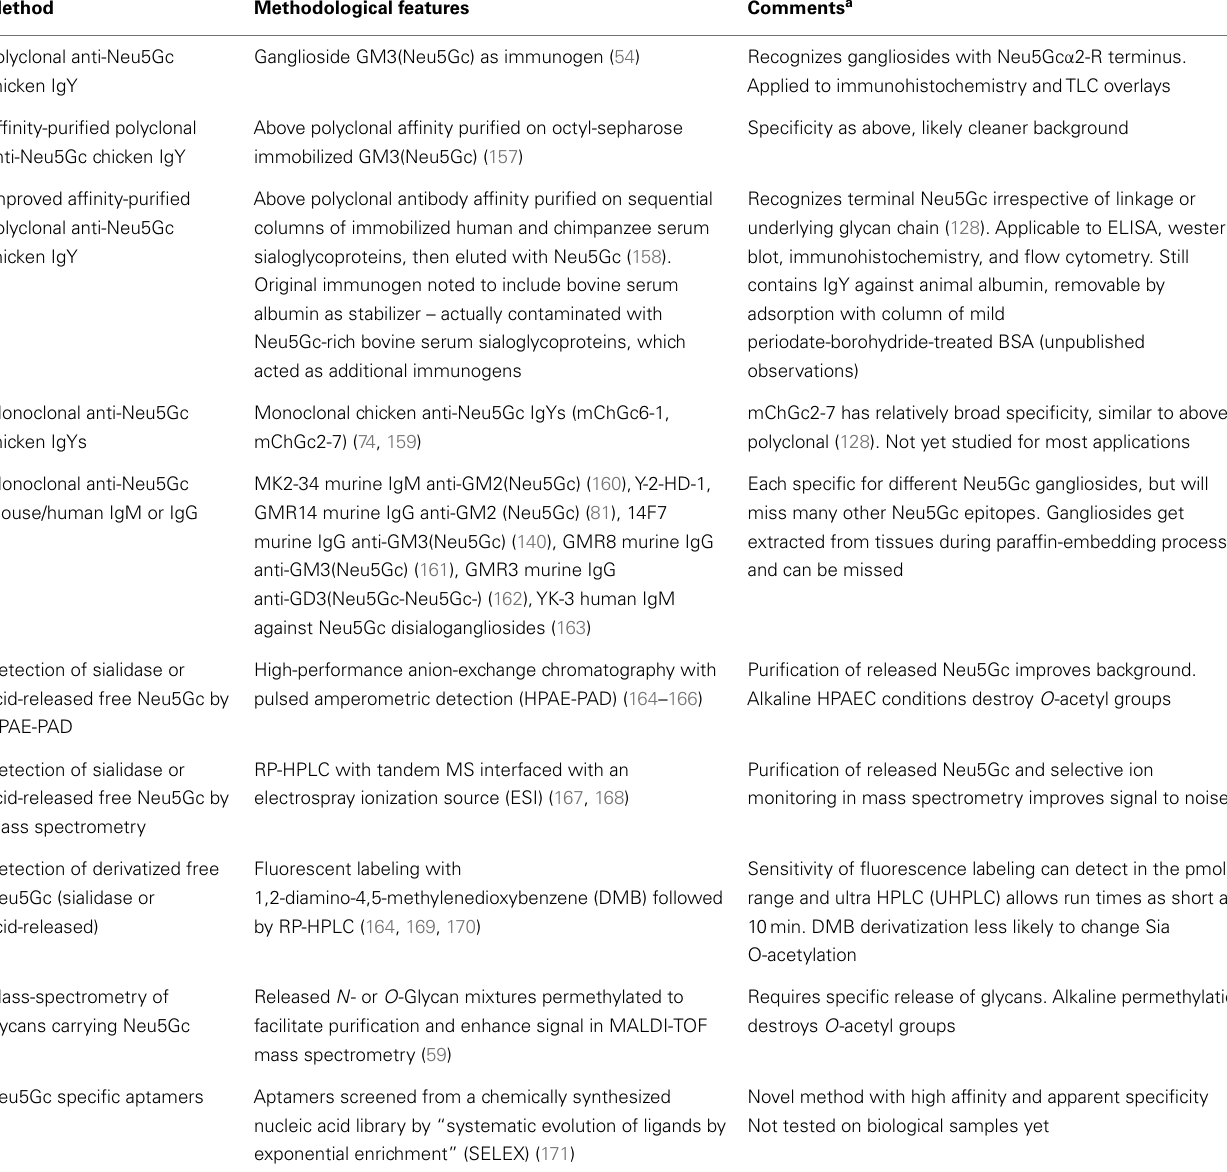
Table 1 | Overview of methods to detect small amounts of